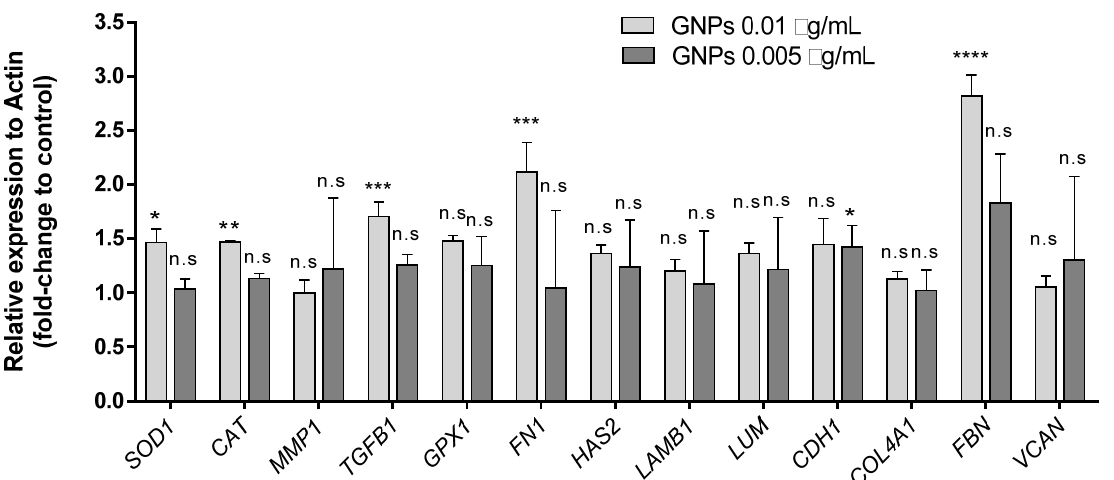
Figure 6. Gene expression in human keratinocyte HaCaT cells exposed at two non-cytotoxic con- centrations (0.005 and 0.01 µ g/mL) of graphene nanoplatelets (GNPs) for 24 h. Data are shown as mean ± standard deviation from three replicates. Thirteen genes ( SOD1 , CAT , MMP1 , TGFB1 , GPX1 , FN1 , HAS2 , LAMB1 , LUM , CDH1 , COL4A1 , FBN, and VCAN ) are analyzed. The results of the statistical analysis are presented as fold-change of control and relative expression to actin beta (ACTB). * p < 0.05; ** p < 0.01; *** p < 0.001, **** p < 0.0001, n.s: not significant.